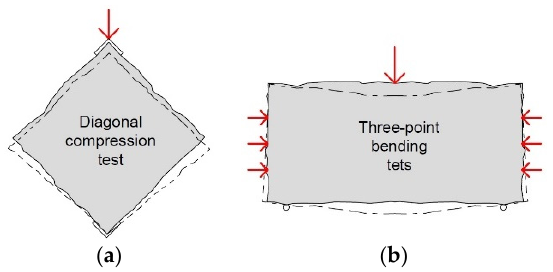
Figure 2. Typical setup for simplified in-plane loading test on masonry elements: ( a ) diagonal compression tests and ( b ) three-point bending tests.